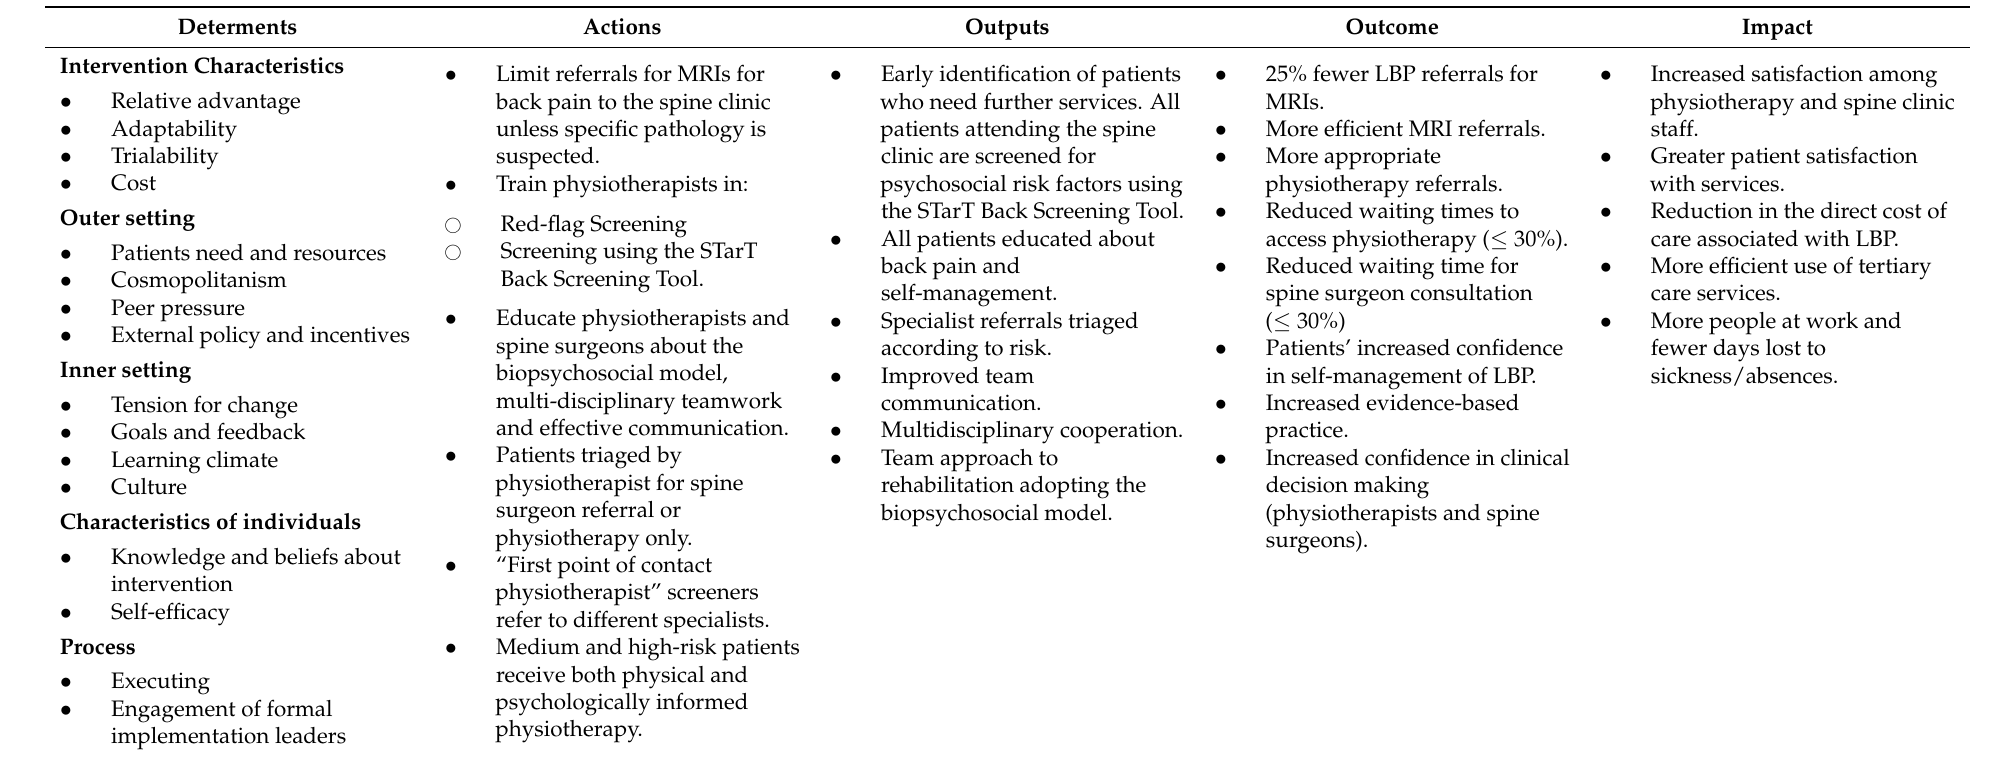
Table 2. Logic model